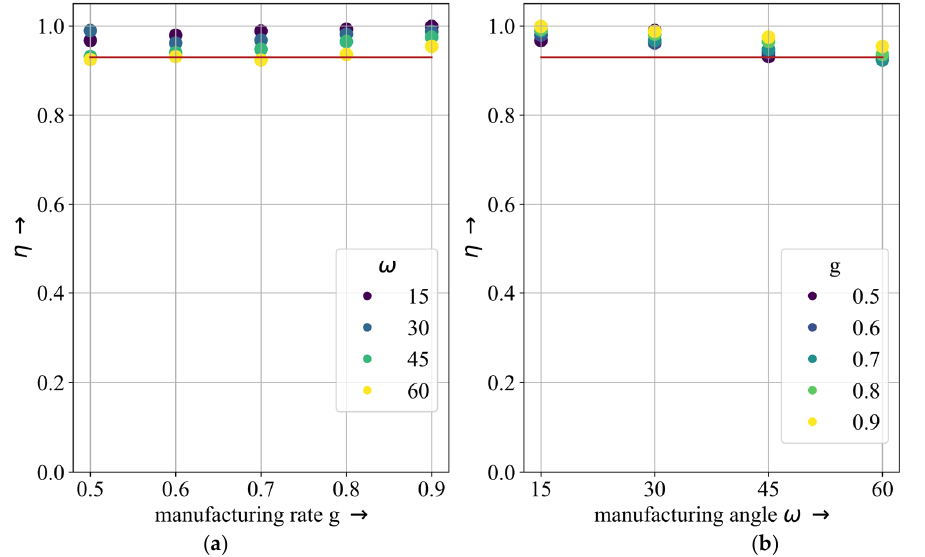
Figure 11. The effective material usage of the rocker design proposals. The red line indicates η of the reference design proposal. ( a ) Shows the effective material usage η as a function of manufacturing rate g; ( b ) Shows the effective material usage η as a function of manufacturing angle ω . The parameters resulted in a η of 99.91%.